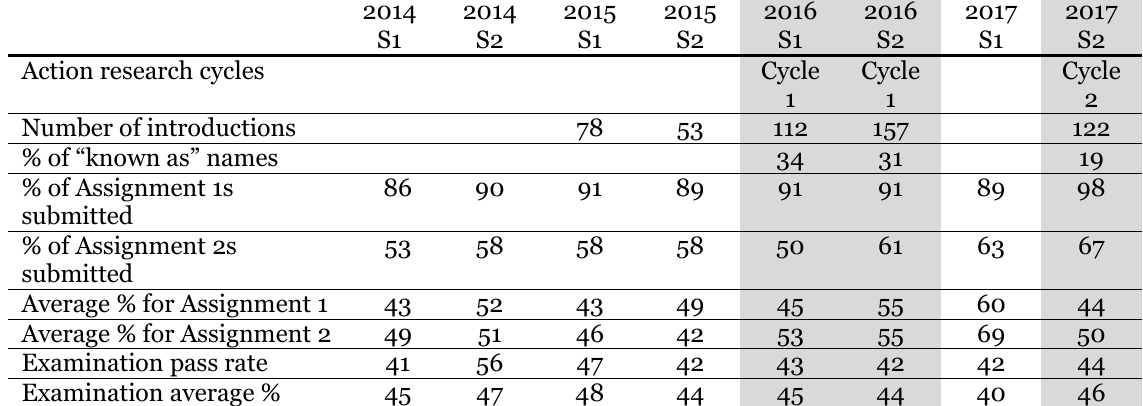
Course Statistics for Students Registered for the Programming Course